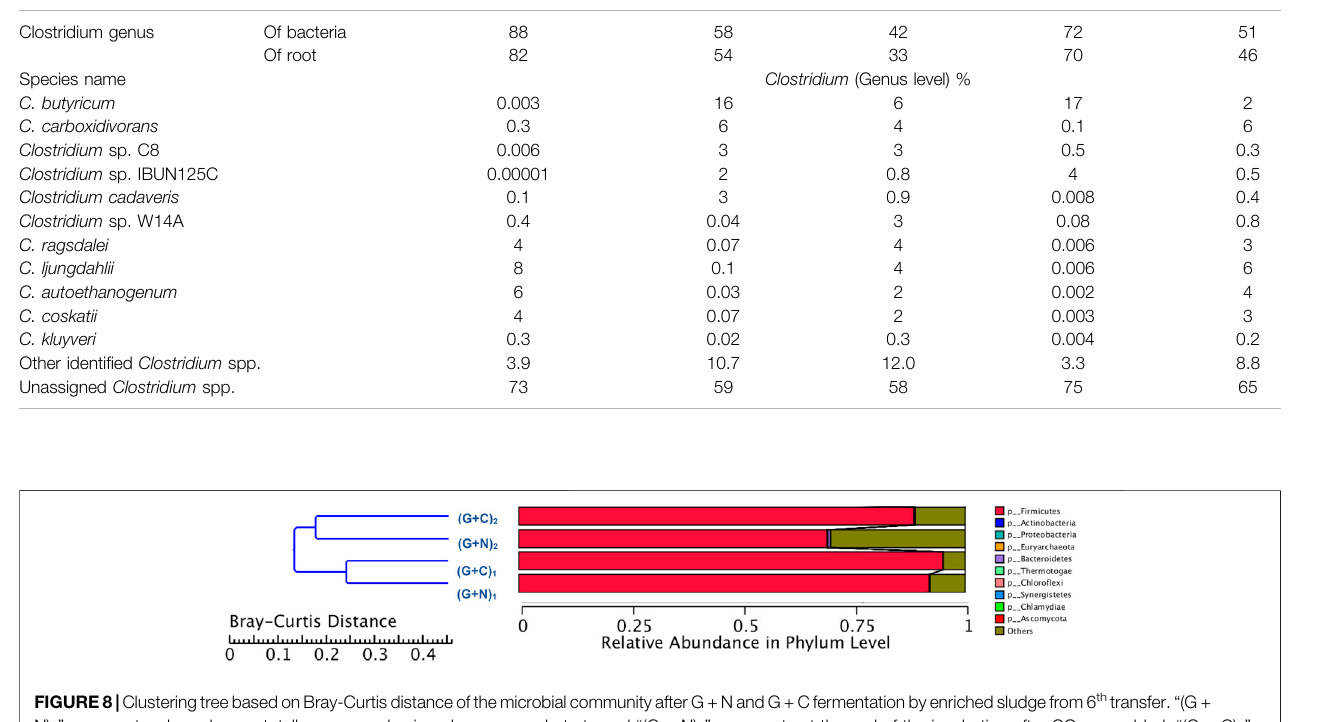
Frontiers in Bioengineering and Biotechnology |